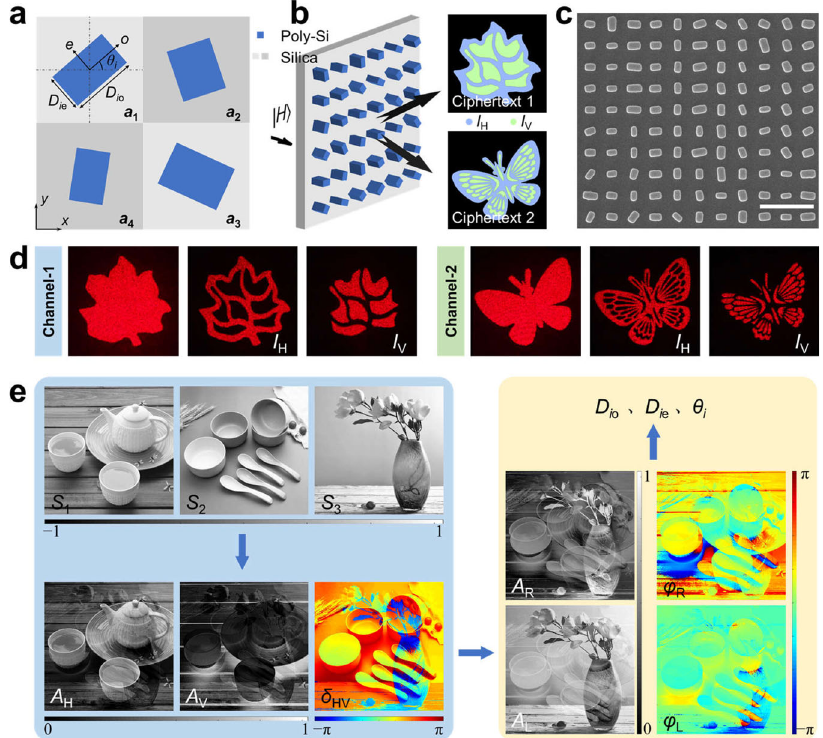
Fig.2|DesignprincipleofStokesmeta-hologram.a Schematicillustrationofthe tetratomic macro-pixel unit cell, which comprises four types of rectangular nano- pillars denoted as meta-atoms a 1 , a 2 , a 3 , and a 4 with variant geometrical sizes D i o and D i e , and orientation angles θ i , ( i = a 1 , a 2 , a 3 , a 4 ). The period and height of the macro-pixelunitcellare900and550nm,respectively. b Workingprincipleofdual-